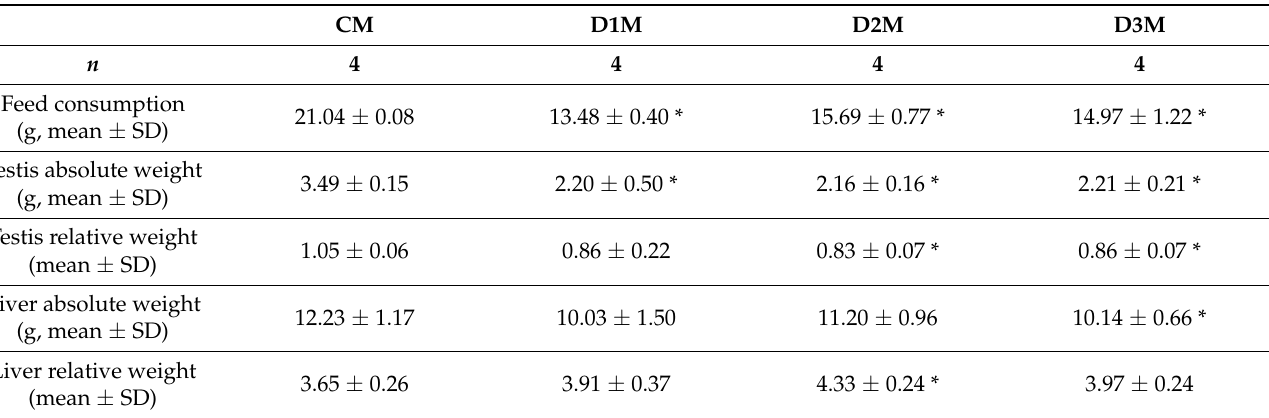
Figure 2. Sperm count of male rats subcutaneously treated with different doses of estradiol valerate plus cyproterone acetate five times a week, for 2 weeks: CM 0—sesame oil, D1M 0.09 + 0.33, D2M 0.09 + 0.93 and D3M 0.18 + 0.33 mg. Panel ( A ) sperm count and ( B ) picture of caudae epididymides. Data are presented as mean ± standard deviation. Statistical significance: * p < 0.05 Mann–Whitney test. n : sperm number. Table 1. General toxicity data of male rats subcutaneously treated with different doses of estradiol valerate plus cyproterone acetate five times a week, for 2 weeks: CM 0 — sesame oil, D1M 0.09 + 0.33, D2M 0.09 + 0.93 and D3M 0.18 + 0.33 mg. Statistical significance: * p < 0.05 Mann – Whitney test. n : number; SD: standard